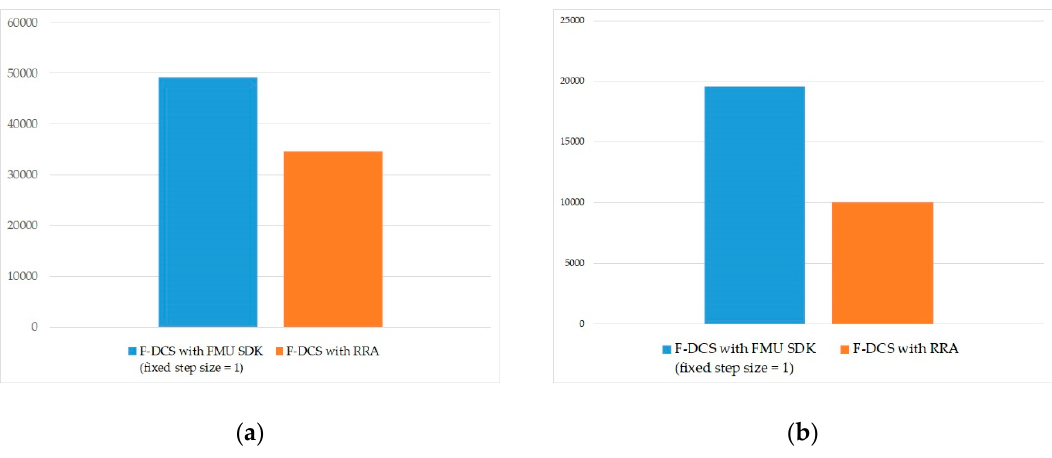
Figure 16. Results of data distribution service (DDS) validation; ( a ) DDS data message, ( b ) DDS control message.